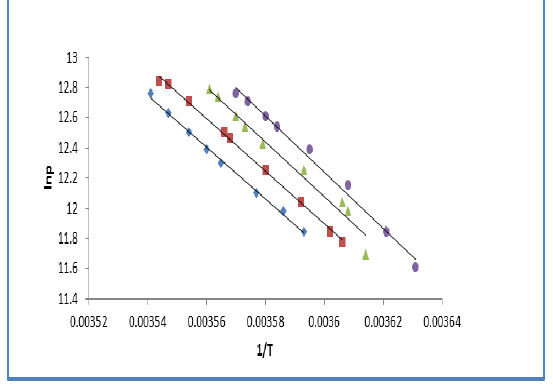
Fig. 13. The logarithms of the dissociation pressures (ln P) versus (1/T) along R134a (V)−water (Lw) −hydrate (H) in the presence and absence KBr coexistence lines ♦ no salt; ■ 0.09 mol ̸ kg; ▲ 0.17 mol ∕ kg; ● 0.26 mol ∕ kg.